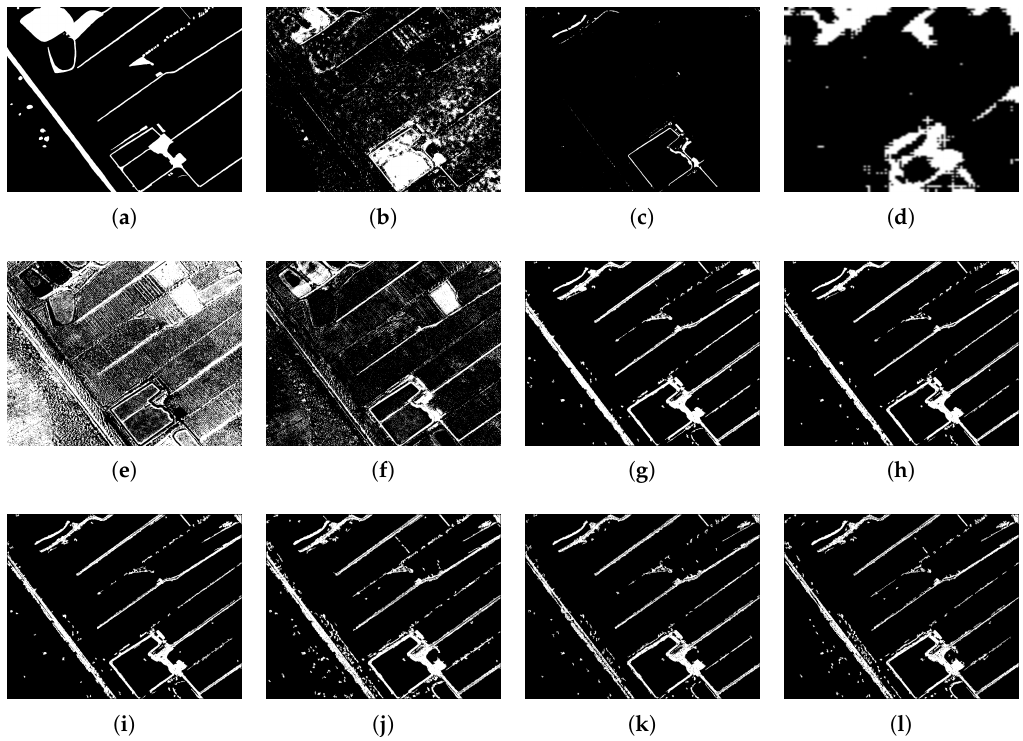
Figure 12. Change detection results of the Farmland Dataset. ( a ) Ground truth; ( b ) IR-MAD; ( c ) PCA-k-means; ( d ) CaffeNet; ( e ) USFA; ( f ) DSFA; ( g ) EM-SDAE: 100-50-20/with dropout; ( h ) EM-SDAE: 200-100-50-20/with dropout; ( i ) EM-SDAE: 500-200-100-50-20/with dropout; ( j ) EM-SDAE: 100-50-20/no dropout; ( k ) EM-SDAE: 200-100-50-20/no dropout; ( l ) EM-SDAE: 500-200-100-50-20/no dropout. Table 3. Quantitative comparison of the Farmland Dataset with other